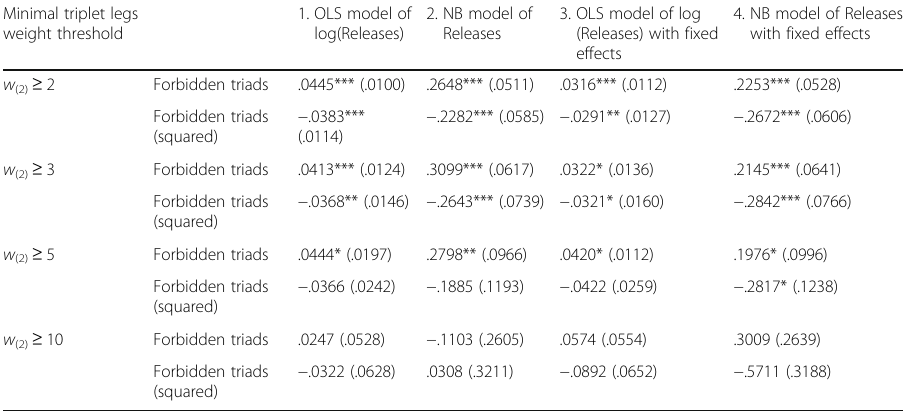
Table 6 Forbidden triads coefficients from statistical models of success with varying minimal triplet legs weight thresholds Minimal triplet legs weight